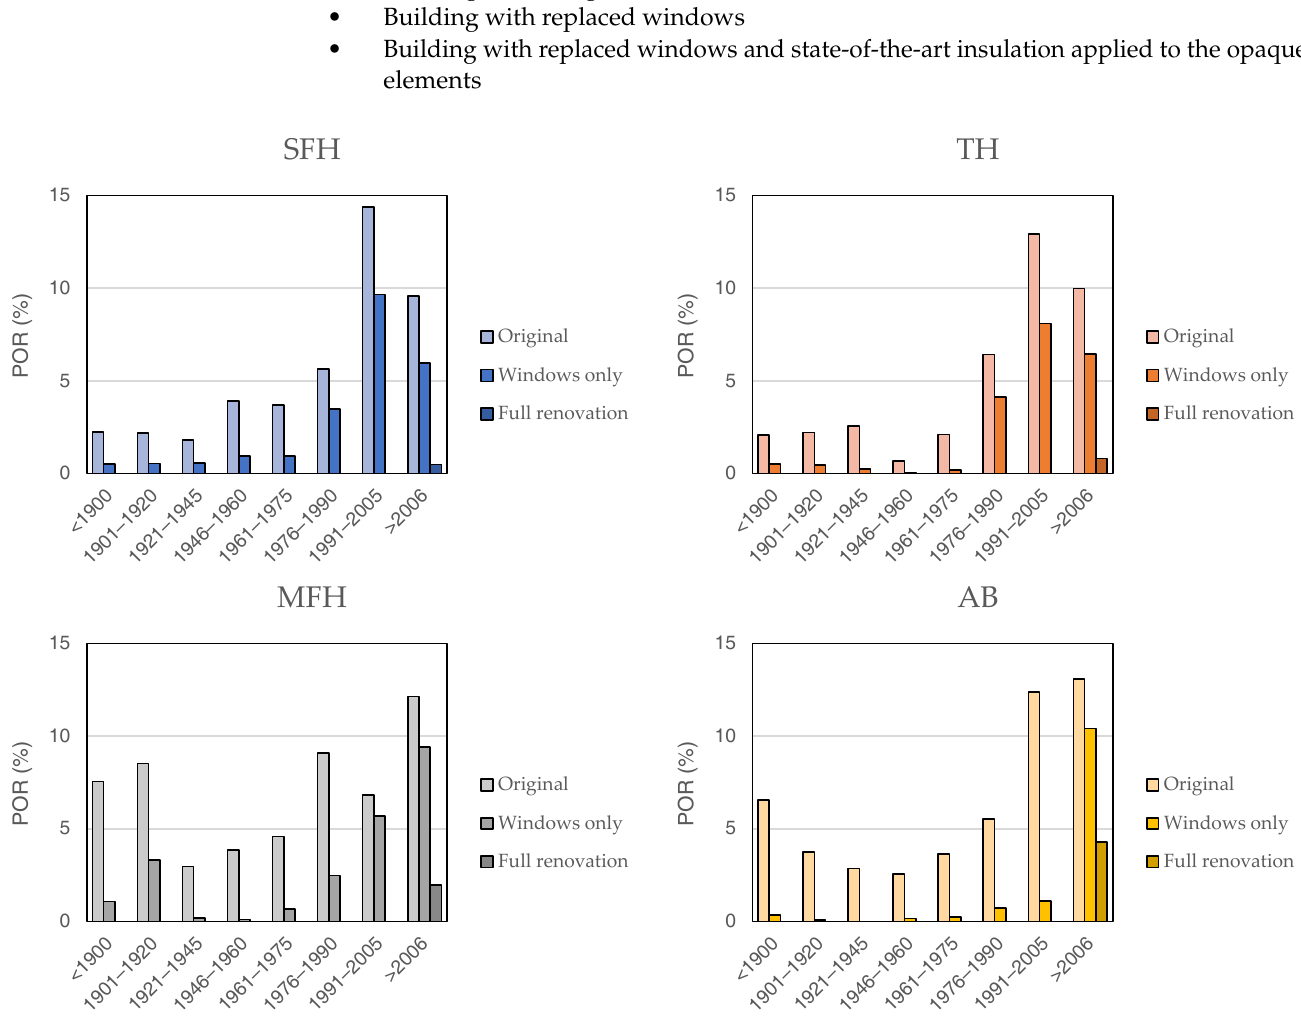
Figure 11. Variation of POR parameter with decreased DH temperature (115 ◦ C to 88 ◦ C) for different retrofit measures on the buildings: original building with no renovation (lightest shade); building with original opaque elements and state-of-the-art windows (intermediate shade); fully renovated building (darkest